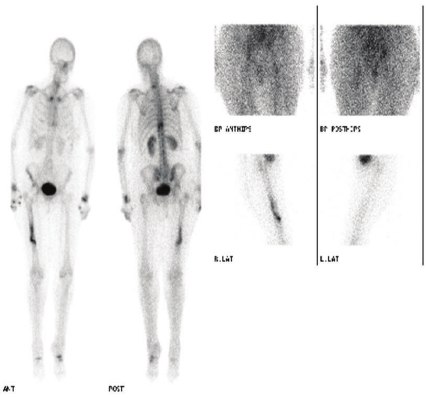
Figure 2: CT scan showing vertical split in right femoral shaft.